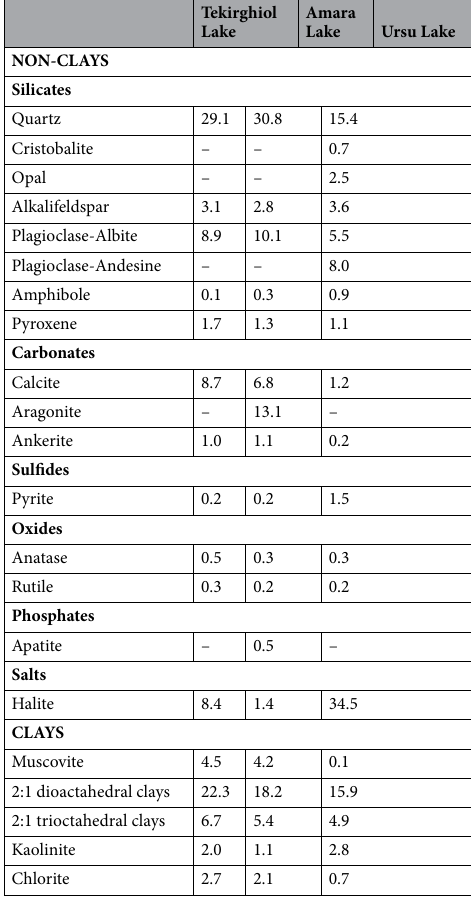
Table 1. Quantitative bulk mineralogical compositions of saline sapropels collected from Tekirghiol, Amara and Ursu lakes. Values are given in weight percentages of the identified